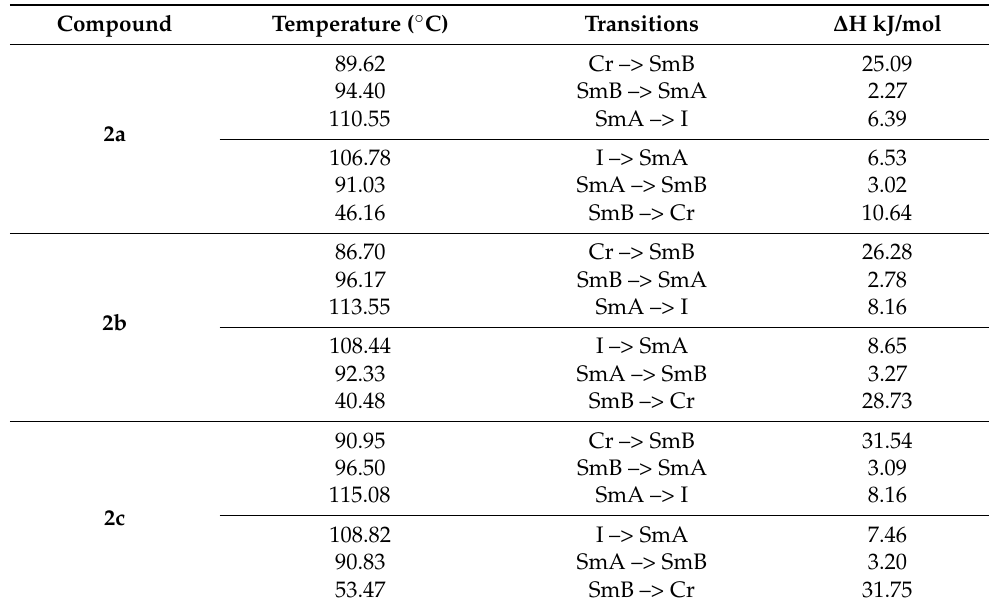
Table 3. Phase transition of compound 2(a – f) . Reprinted/adapted with permission from Ref. [26]; published by Elsevier, 2012.